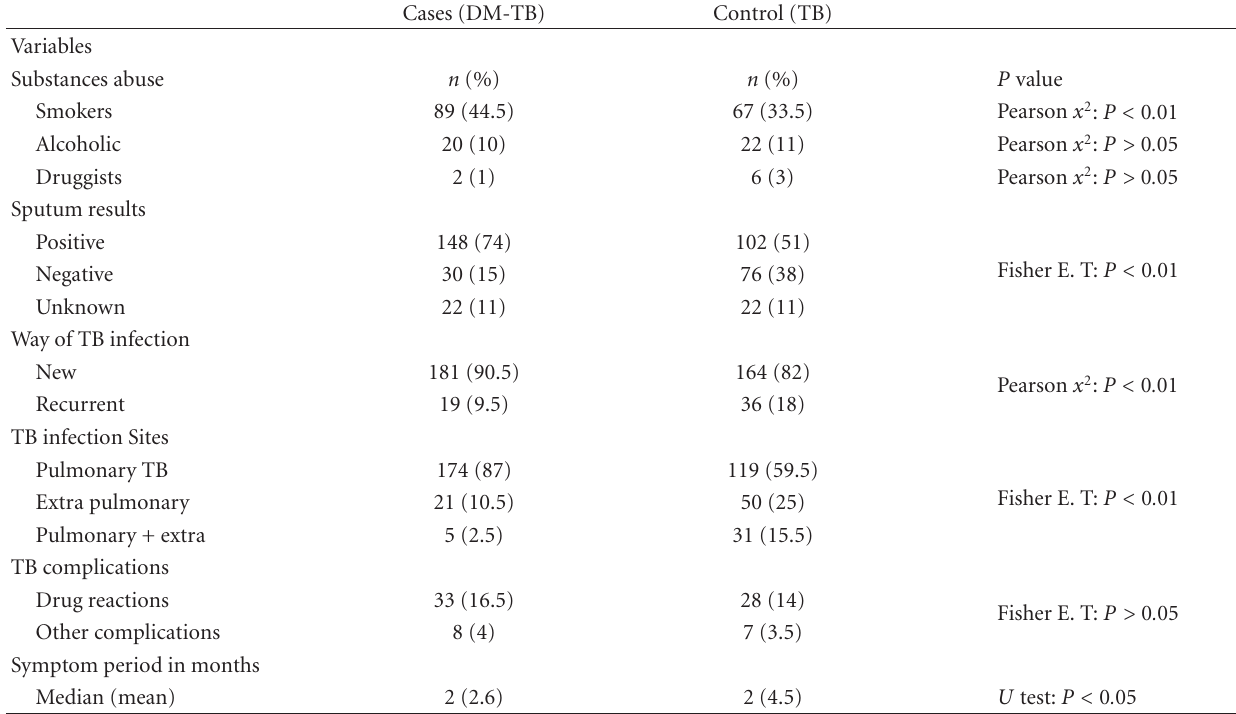
Table 3: Substance abuse and TB-related variables among TB groups.